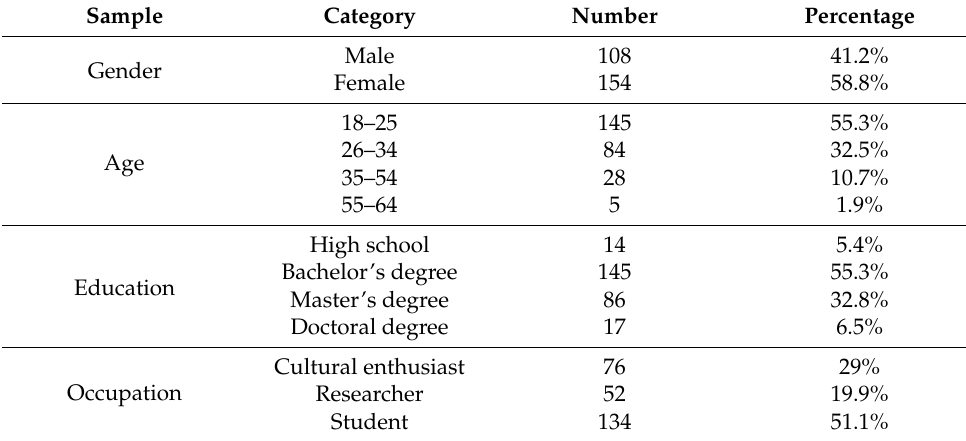
Table 1. Demographic information of respondents.